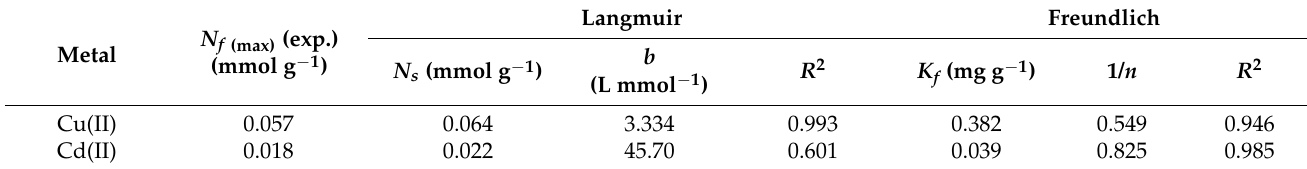
Table 3. Parameters and correlation coefficients for Langmuir and Freundlich models. The obtained experimental maximum adsorption capacities for each metal can also be found for comparison.